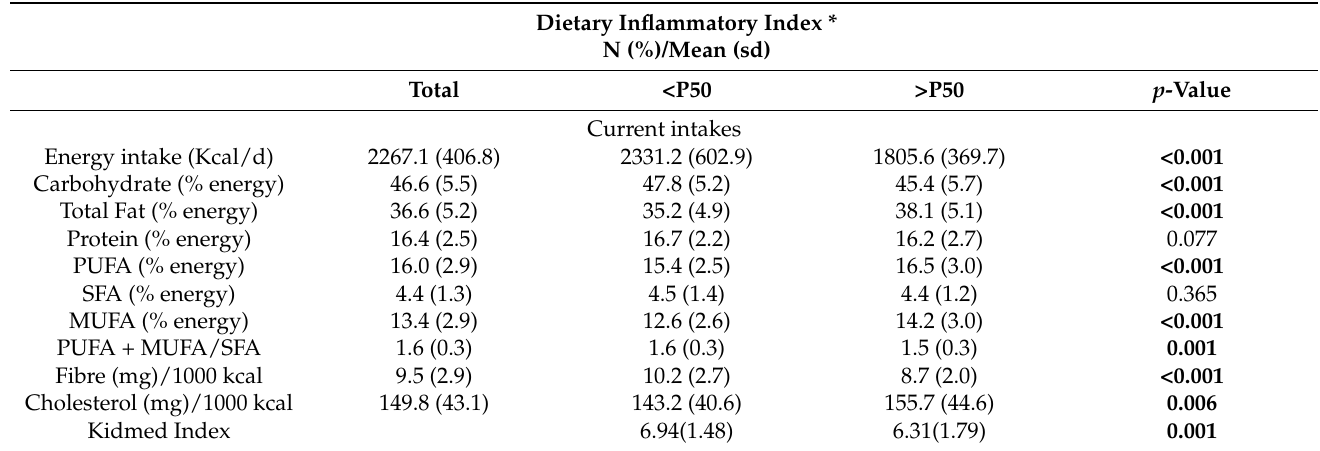
Table 3. Differences in nutrient intake and diet quality among subjects with or without a dietary inflammatory index above the 50th percentile.